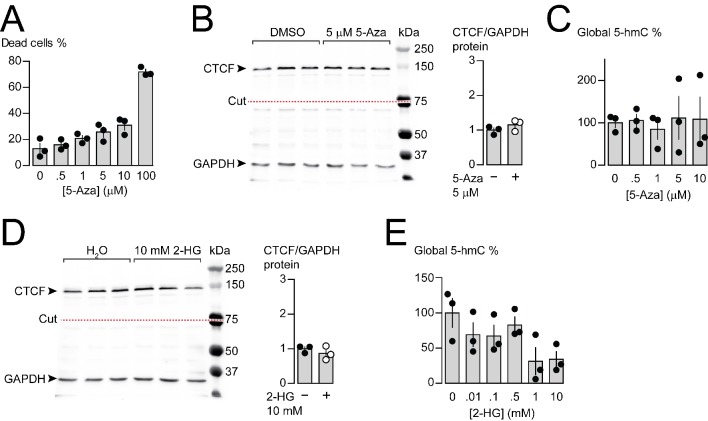
Effects of 5-Azacytidine and 2-hydroxyglutarate on cytotoxicity, CTCF and 5-hmC levels in F11 cells.(A) F11 cytotoxicity with different concentrations of 5-Azacytidine (5-Aza) for 3 days (ANOVA P value = <0.0001, Dunnett’s multi-comparison P values for 0 vs 0.5 μM = 0.9380, 0 vs 1 μM = 0.3112, 0 vs 5 μM = 0.0518, 0 vs 10 μM = 0.0061, 0 vs 100 μM = <0.0001) (three biological replicates per condition). (B) CTCF protein levels in F11 cells after 3 days of control (DMSO) or 5 μM 5-Aza treatment. Anti-CTCF identifies a single band at ~135 kDa. Transfer membrane was cut at ~75 kDa (dotted red line) and the lower part treated with anti-GAPDH to measure GAPDH levels for protein expression and loading reference. CTCF protein levels relative to GAPDH (t-test P value = 0.2637 for DMSO vs 5-Aza) (three biological replicates per condition). (C) Global 5-hydroxymethylcytosine (5-hmC) levels in F11 cells after 3 days exposure to different concentrations of 5-Aza (ANOVA P value = 0.9832, Dunnett’s multi-comparison P values for 0 vs 0.5 μM = 0.9998, 0 vs 1 μM = 0.9935, 0 vs 5 μM = 0.9975, and 0 vs 10 μM = 0.99971) (three biological replicates per condition). (D) CTCF protein levels in F11 cells after 1 day of control (H2O) or 10 mM 2-hydroxyglutarate (2-HG) treatment. Anti-CTCF identifies a single band at ~135 kDa. Transfer membrane was cut at ~75 kDa (dotted red line) and the lower part treated with anti-GAPDH to measure GAPDH levels for protein expression and loading reference. CTCF protein levels relative to GAPDH (t-test P value = 0.3716 for H2O vs 2-HG) (three biological replicates per condition). (E) Global 5-hmC levels in F11 cells after 1 day exposure to different concentrations of 2-HG (ANOVA P value = 0.0667, Dunnett’s multi-comparison P values for 0 vs 0.01 mM = 0.5444, 0 vs 0.1 mM = 0.4971, 0 vs 0.5 mM = 0.9087, 0 vs 1 mM = 0.0417, and 0 vs 1 mM = 0.0511) (three biological replicates per condition). Biological replicates represent independent cell cultures, treatment and transfections.